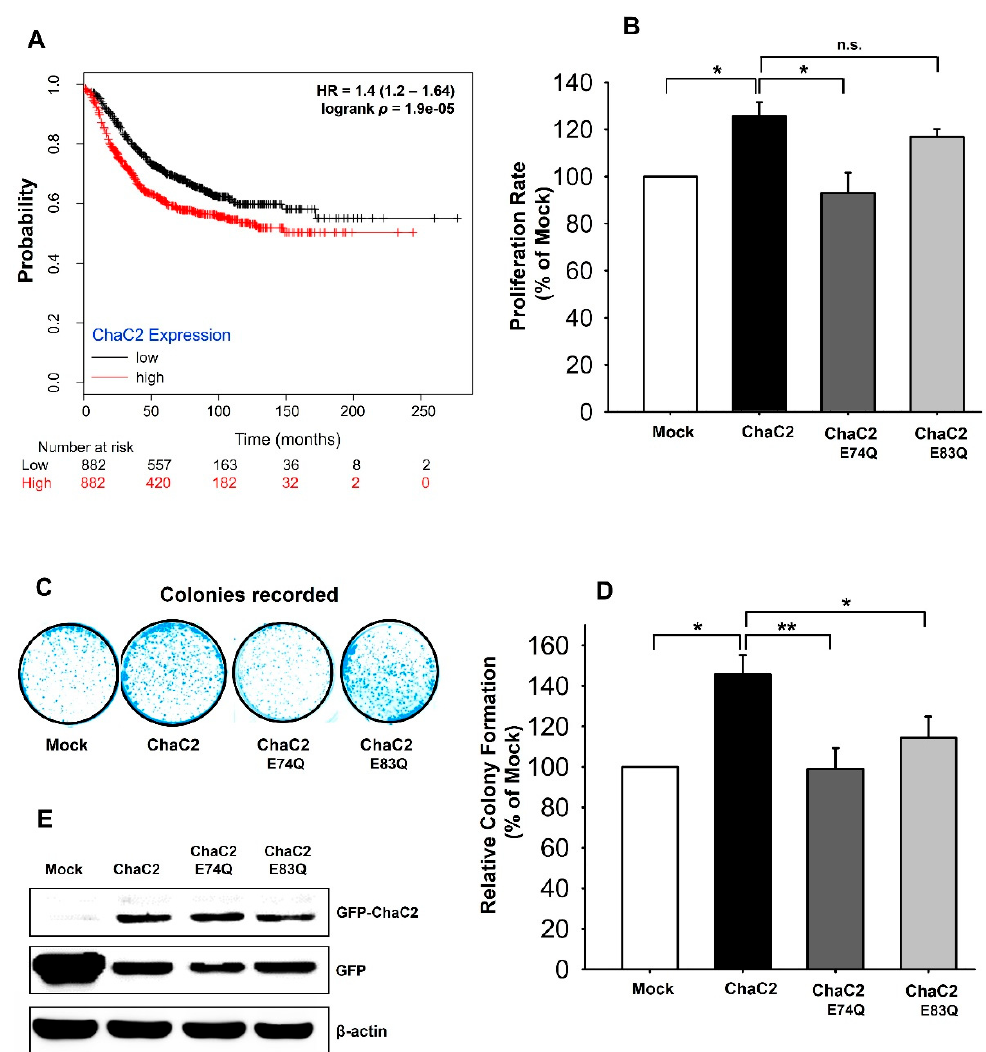
Figure 7. Proliferation of breast cancer cell lines by ChaC2 overexpression. ( A ) The Kaplan–Meier plots according to ChaC2 expression levels in patients with breast cancer. The plots show lower survival rates in patients with high ChaC2 expression compared to low ChaC2 expression. ( B ) Viability of ChaC2-overexpressed MCF-7 cells measured by MTT assay. The proliferation rate of cells is shown with relative percentages compared to the Mock-transfected cells. Data represent the mean ± SEM (error bars) of three independent experiments. Asterisks indicate statistically significant differences; * p < 0.05; ** p < 0.01; n.s. (no significance), p ≥ 0.05. ( C , D ) Colony forming assay with ChaC2-overexpressed MCF-7 cells. The representative photos were taken after 2 weeks from initial seeding ( C ). The relative percentages of the colony numbers of the ChaC2, ChaC2 E74Q, and ChaC2 E83Q-transfected cells to Mock-transfected cells are represented as the mean ± SEM (error bars) of three independent experiments ( D ). ( E ) The overexpression of ChaC2 in the ChaC2-transiently transfected MCF-7 cells. Cell lysates of the Mock, ChaC2, ChaC2 E74Q, and ChaC2 E83Q-transfected cells were analyzed by western blotting using a GFP antibody to detect GFP-tagged ChaC2